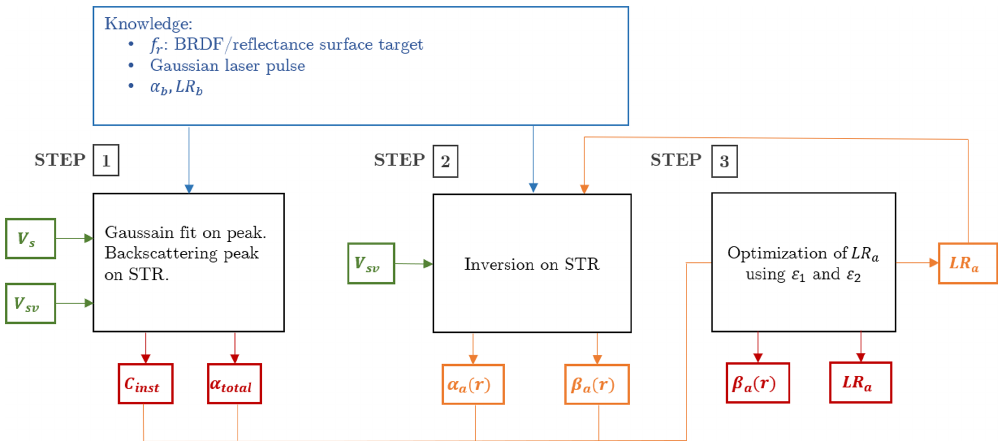
Figure 2. Diagram illustrating how the inversion algorithm allows one to retrieve the β a (r) and LR a without assumptions about the volume medium of interest. In green are the lidar signals inputs; in orange are the intermediate calculations during the optimization procedure, and in red are the code outputs.